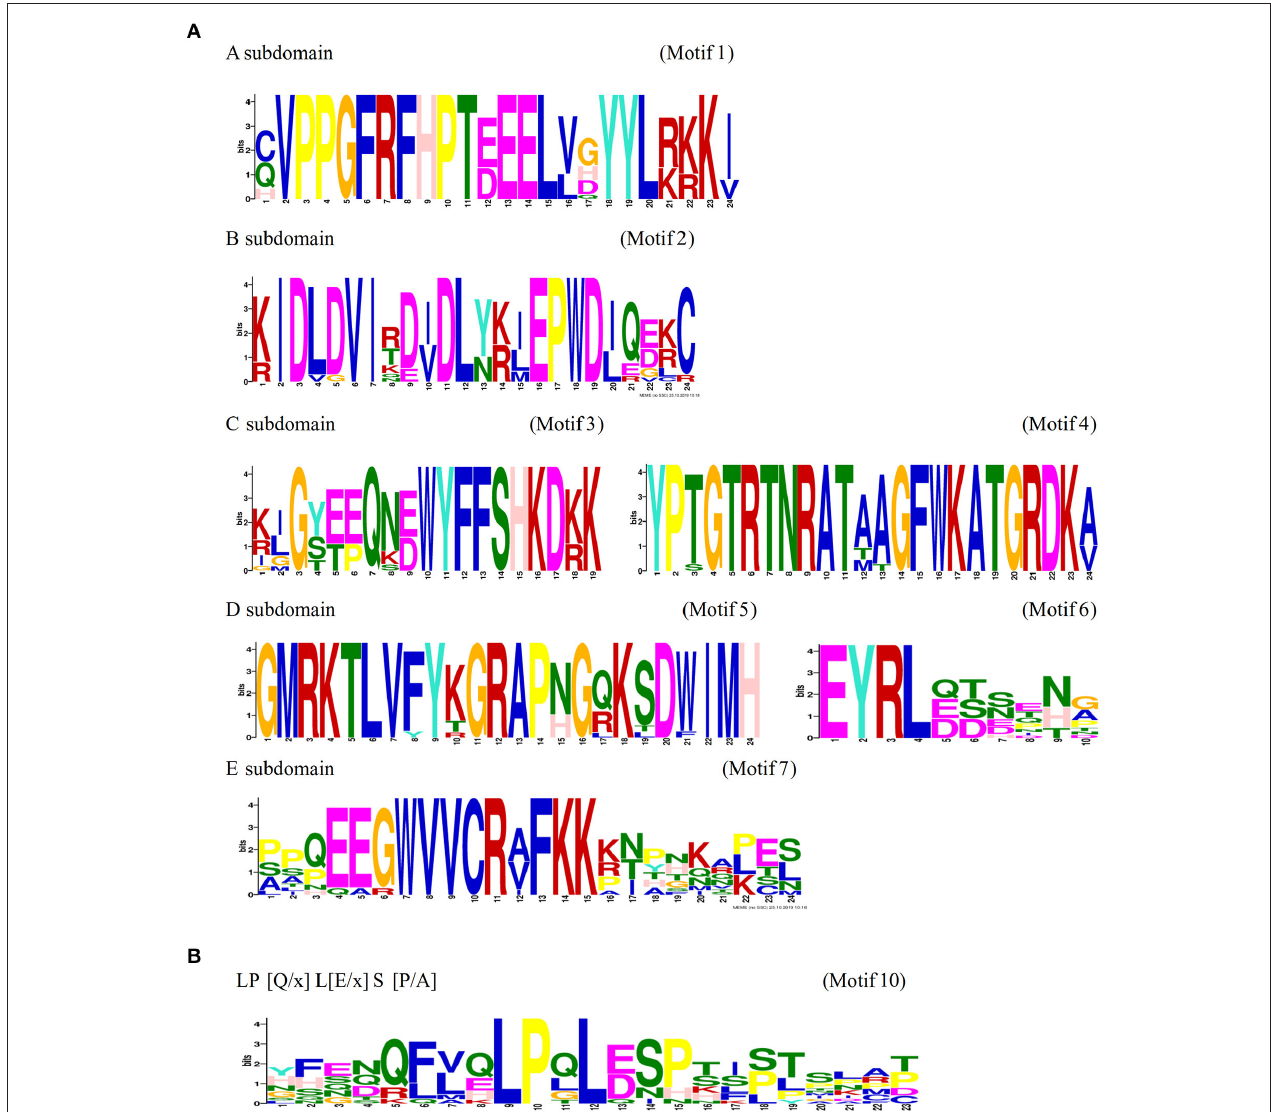
FIGURE 3 | Sequence-specific MEME motifs for NtVNDs and NtNSTs. (A) A–E subdomains were marked in the top left corner, and their corresponding motif numbers are shown in Figure 2C were indicated in the top right corner. (B) The LP [Q/x] L[E/x] S [P/A] motif, namely motif 10, is also